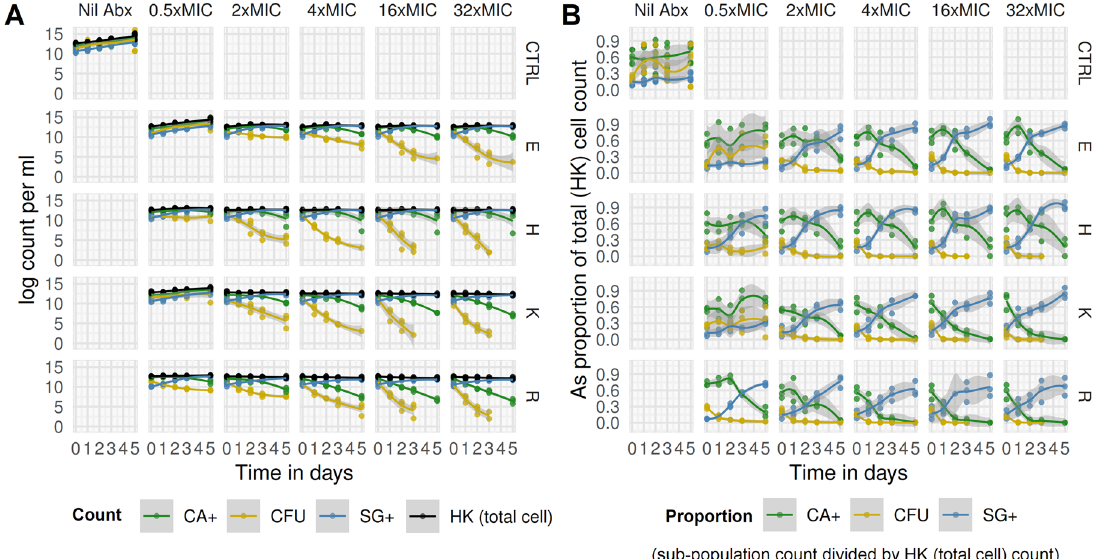
Figure 9. Time-kill curves generated through FCM defined cell populations and CFU counts. Data from three replicates. Counts (left panel) and proportions (right panel) by cell population [CA + = Calcein-AM- stained in live samples; CFU = colony forming units; SG + = SYBR-gold-stained in live samples; HK = SYBR- gold-stained in heat-killed samples] over time by antimicrobial condition. Antimicrobial indicated by letter in rows (E, ethambutol; H, isoniazid; K, kanamycin; R, rifampicin; CTRL, antimicrobial-free [“Nil Abx”] broth) and concentration in multiples of MIC in columns. Non-parametric Loess regression line and shaded 95% confidence intervals shown. Proportions are derived using HK count as a total cell count denominator (i.e. CA + /HK, SG + /HK,